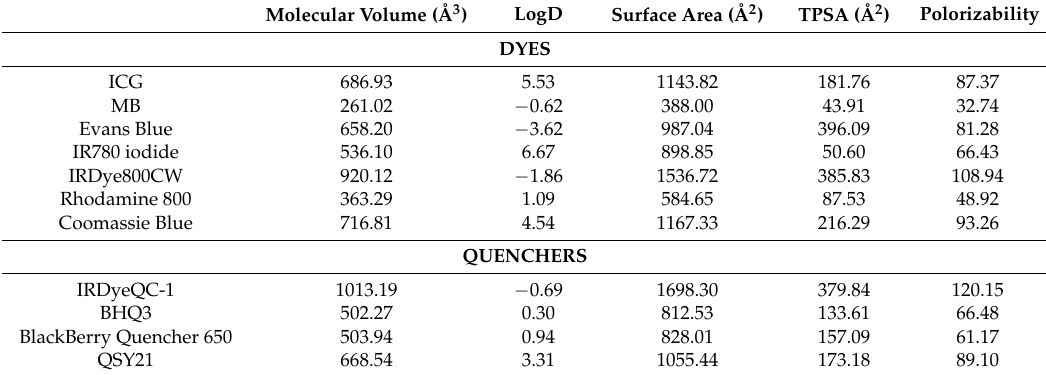
Table 2. Physicochemical properties of selected dyes and quenchers calculated using